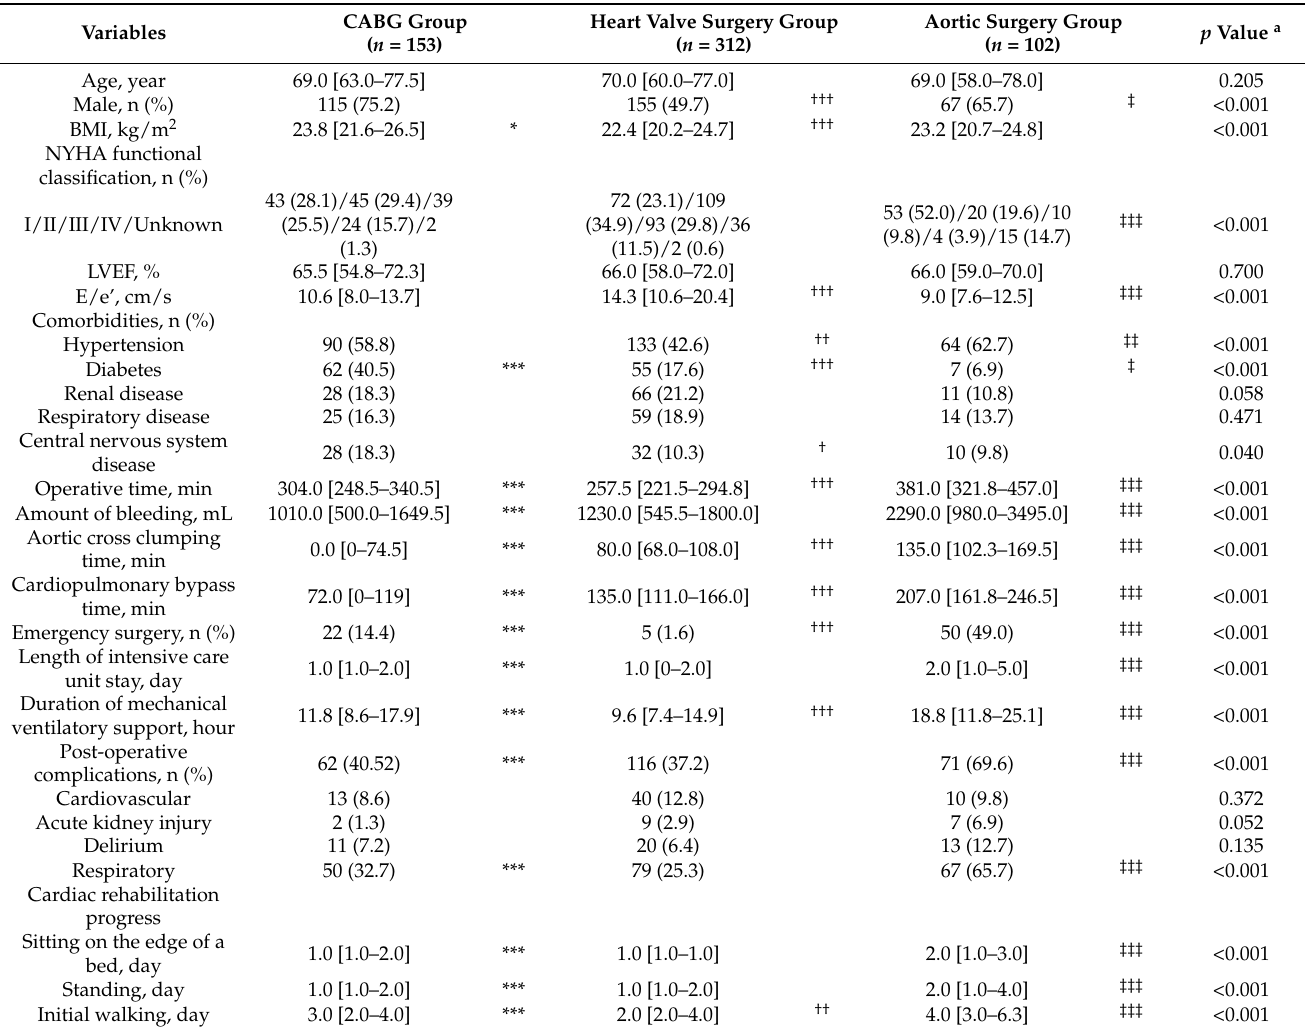
Table 1. Demographics and peri-operative data of